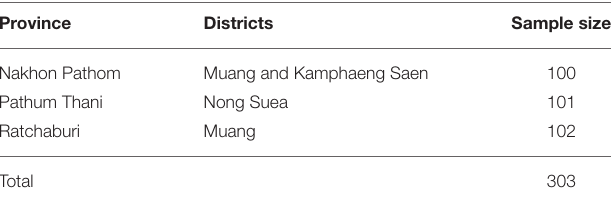
TABLE 1 | Sample of vegetable farmers used for the study in Thailand,